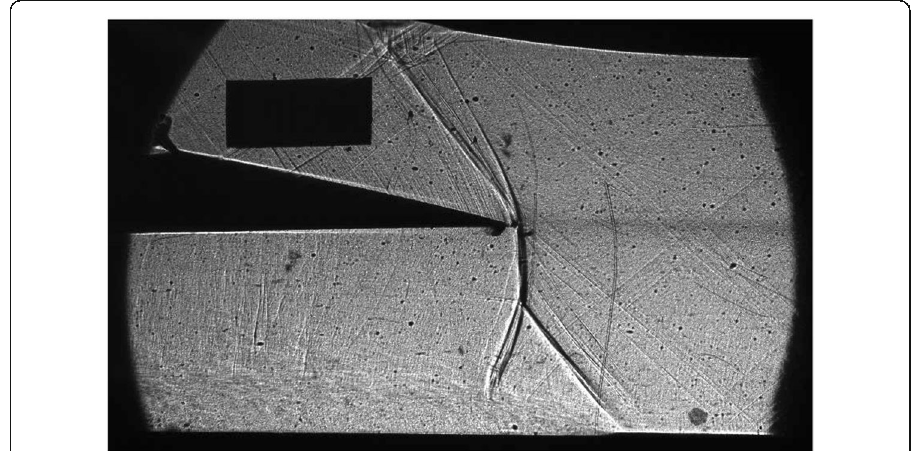
Fig. 1 Shadowgraph flow visualization image for data acquired on 05 April 2018, illustrating the presence of a normal shock wave, lambda foot, and separated turbulent boundary layer within the lower flow passage, and an oblique shock wave system within the upper flow